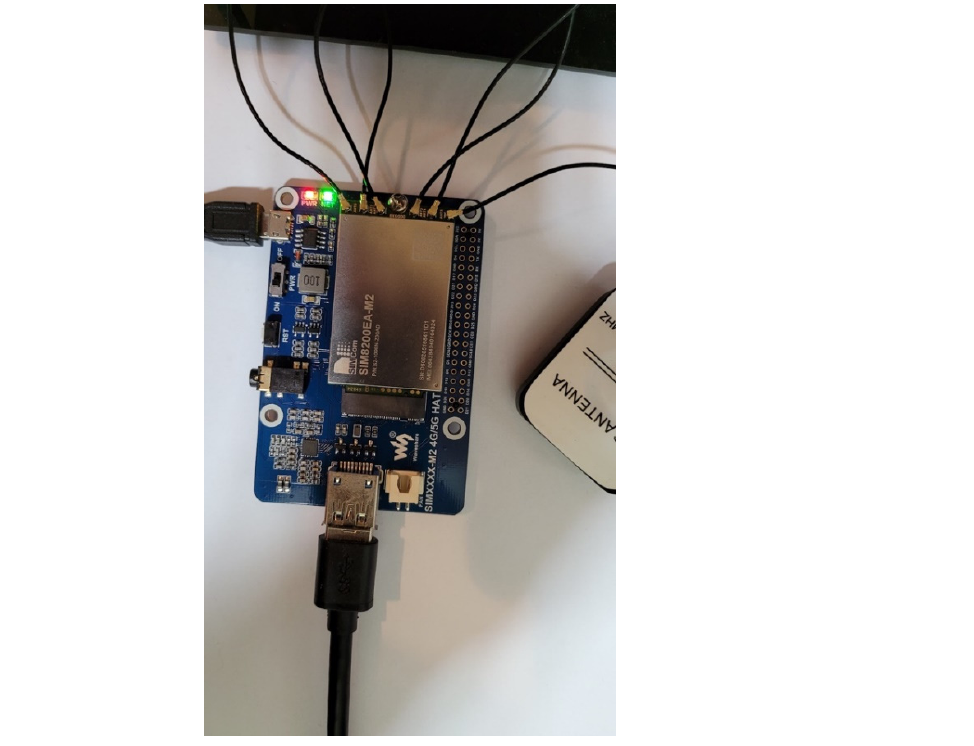
Figure 22. The 5G-dedicated antenna connection used in our experiments. After completion of the wiring and installation of drivers, the device administrator of the computer system displayed the Qualcomm Snapdragon X55 5G item in the network device, as shown in Figure 23. This situation indicates that the 5G communication module was successfully installed, and that the system could then use 5G communications to transmit data.